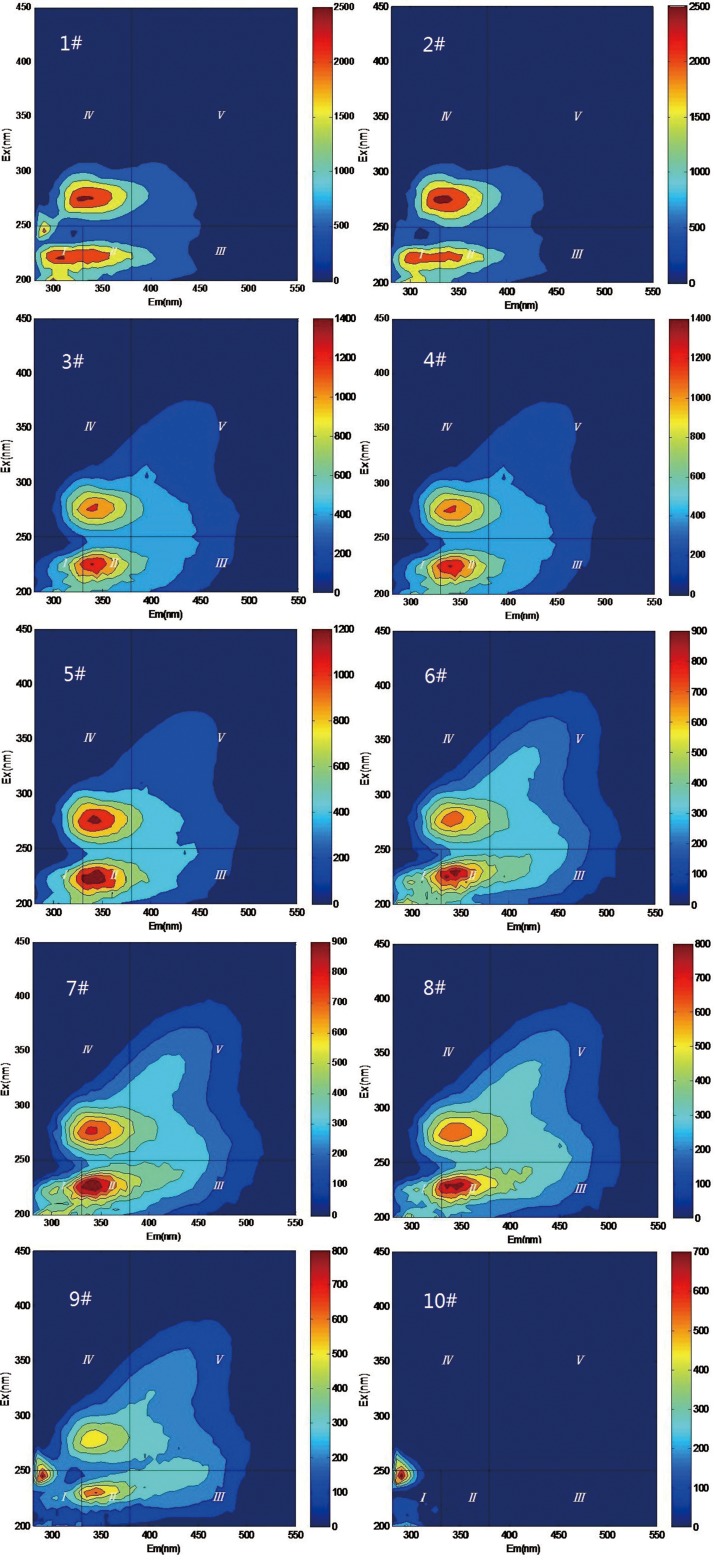
EEM spectra of water samples.